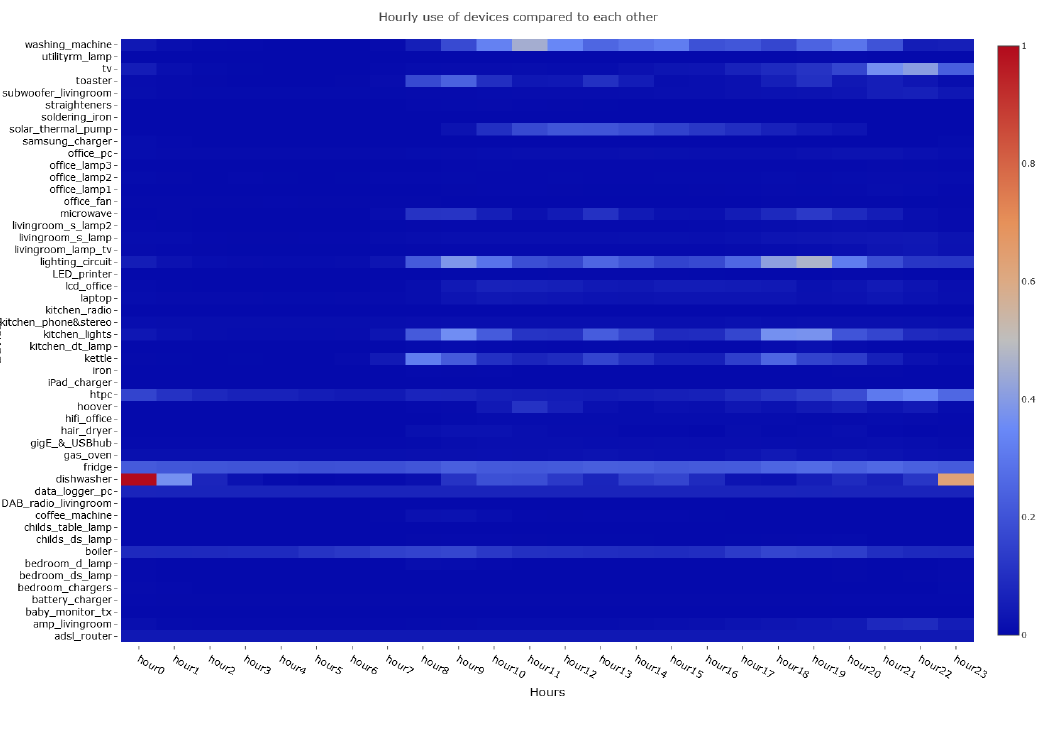
Figure 5. Hourly use of devices compared to each other.